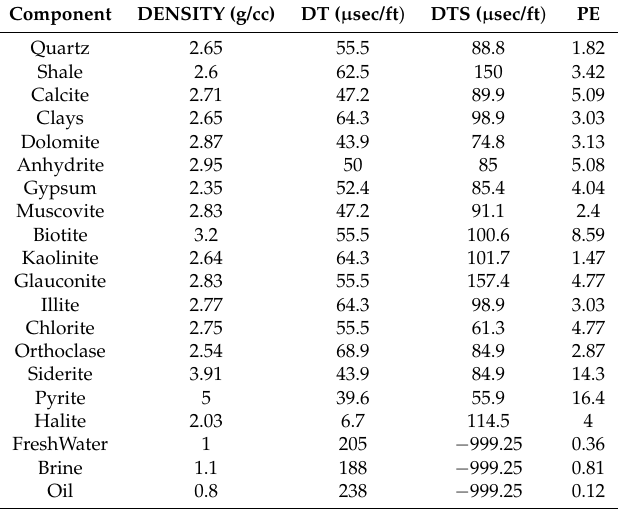
Figure 2. Interactive graphical user interface (GUI) for the MinInversion program. Inset image shows composition analysis of well log data from the Permian Basin calculated using the LU-decomposition method. Table 1. Table showing a section of the library of Petrophysical properties compiled from several sources. For composite constituents such as clays, values corresponding to dry samples should be used. The values can be edited by the user. DT and DTS stand for compressional and shear wave slowness respectively. The value − 999.25 is used to represent values that are not